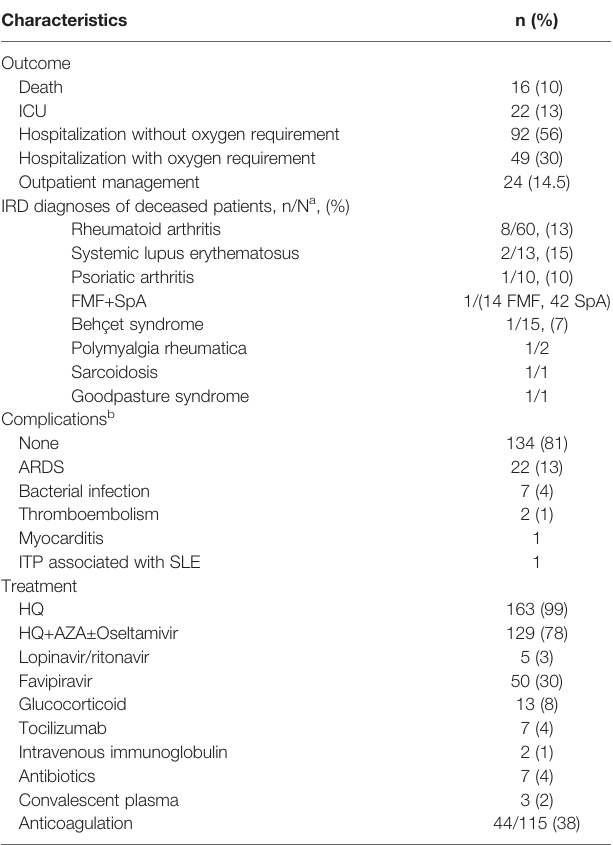
TABLE 2 | Management and outcome of COVID-19 in IRD patients.